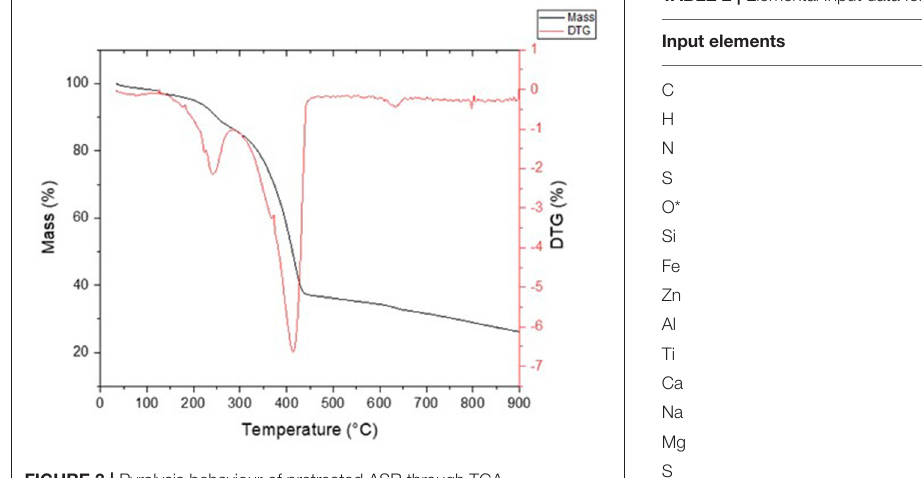
FIGURE 3 | Pyrolysis behaviour of pretreated ASR through TGA.